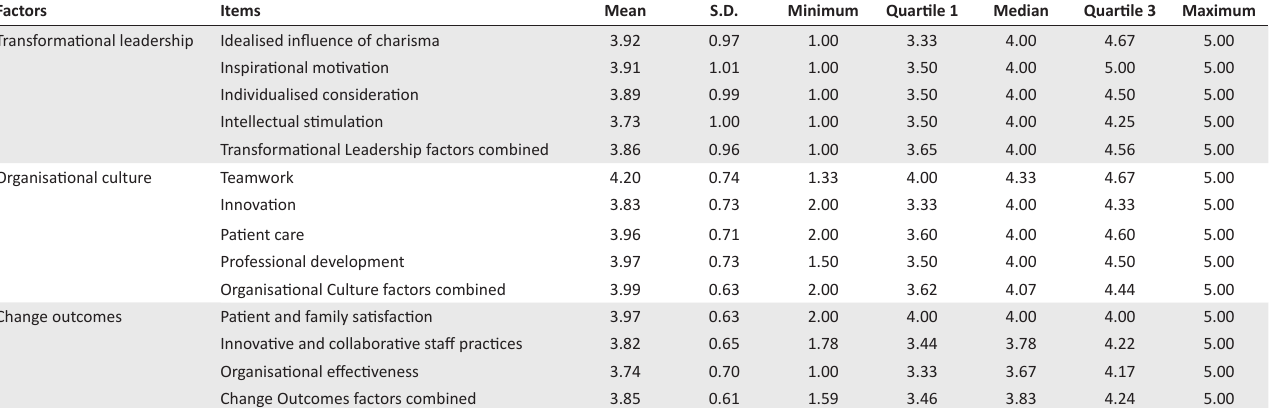
TABLE 4: Measures of central tendency and dispersion – Transformational leadership, organisational culture and change outcomes. Factors Items Mean Transformational